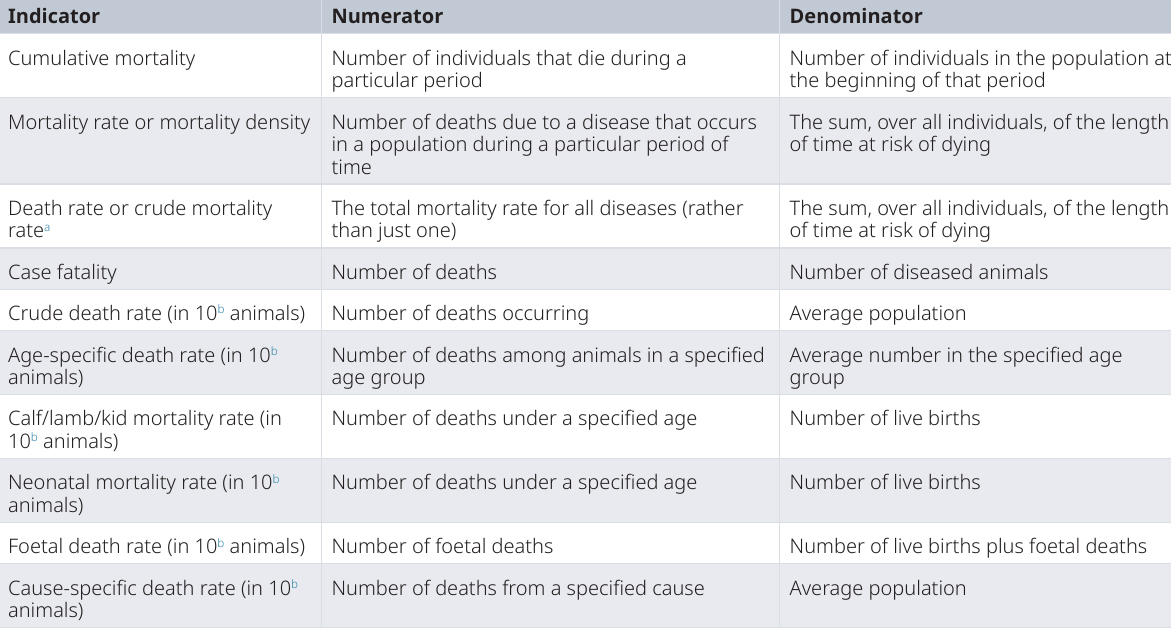
Table 2. Mortality indicators used in veterinary epidemiology ( Thrusfield & Christley, 2018